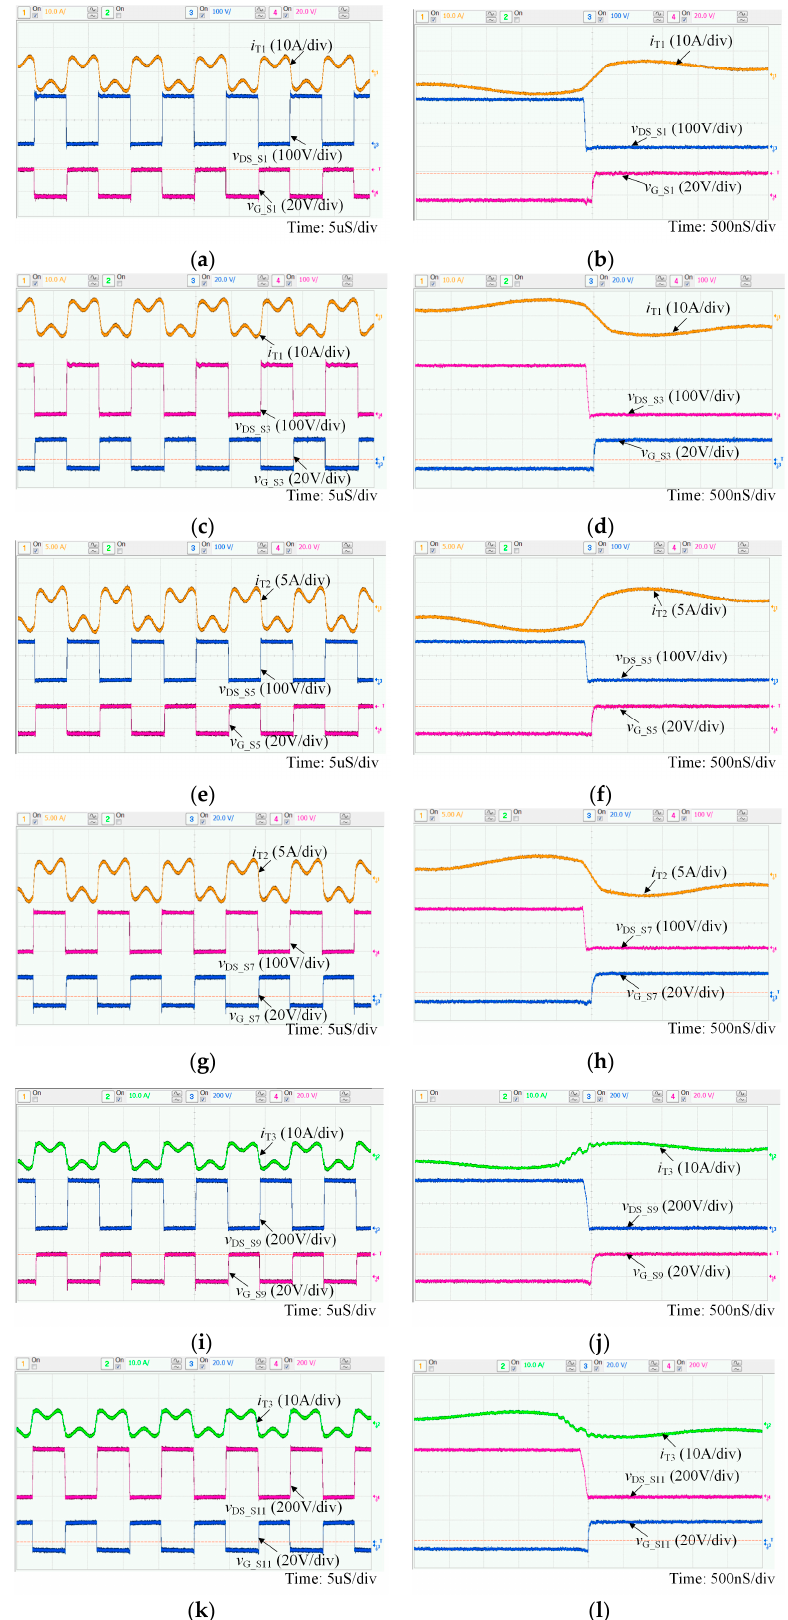
Figure 11. Experimental results of MR-TP-BDC under forward rated condition: ( a ) output voltage and current of port 3; ( b ) resonant currents of three ports.